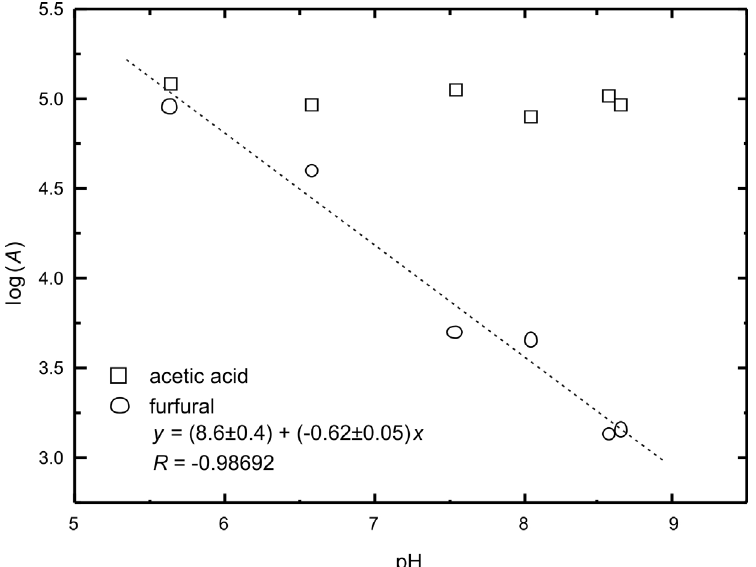
Figure 3. Comparison of chromatographic peak areas for acetic acid and furfural emitted by cellulosic samples (Whatman filter paper no.1) impregnated with different phosphate buffers after an